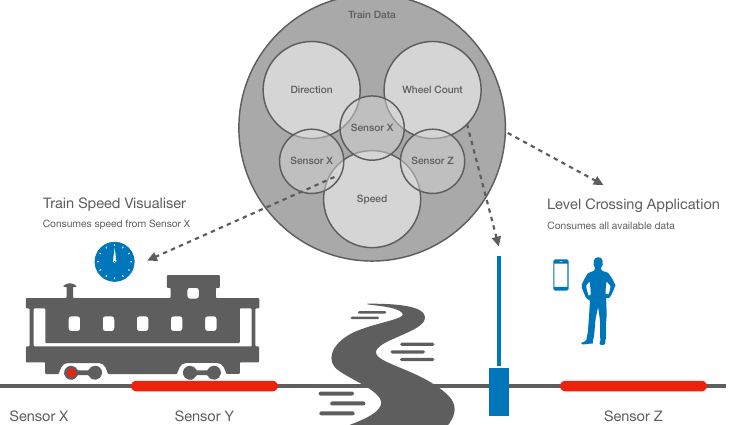
Figure 2. Motivational scenario: IoT data